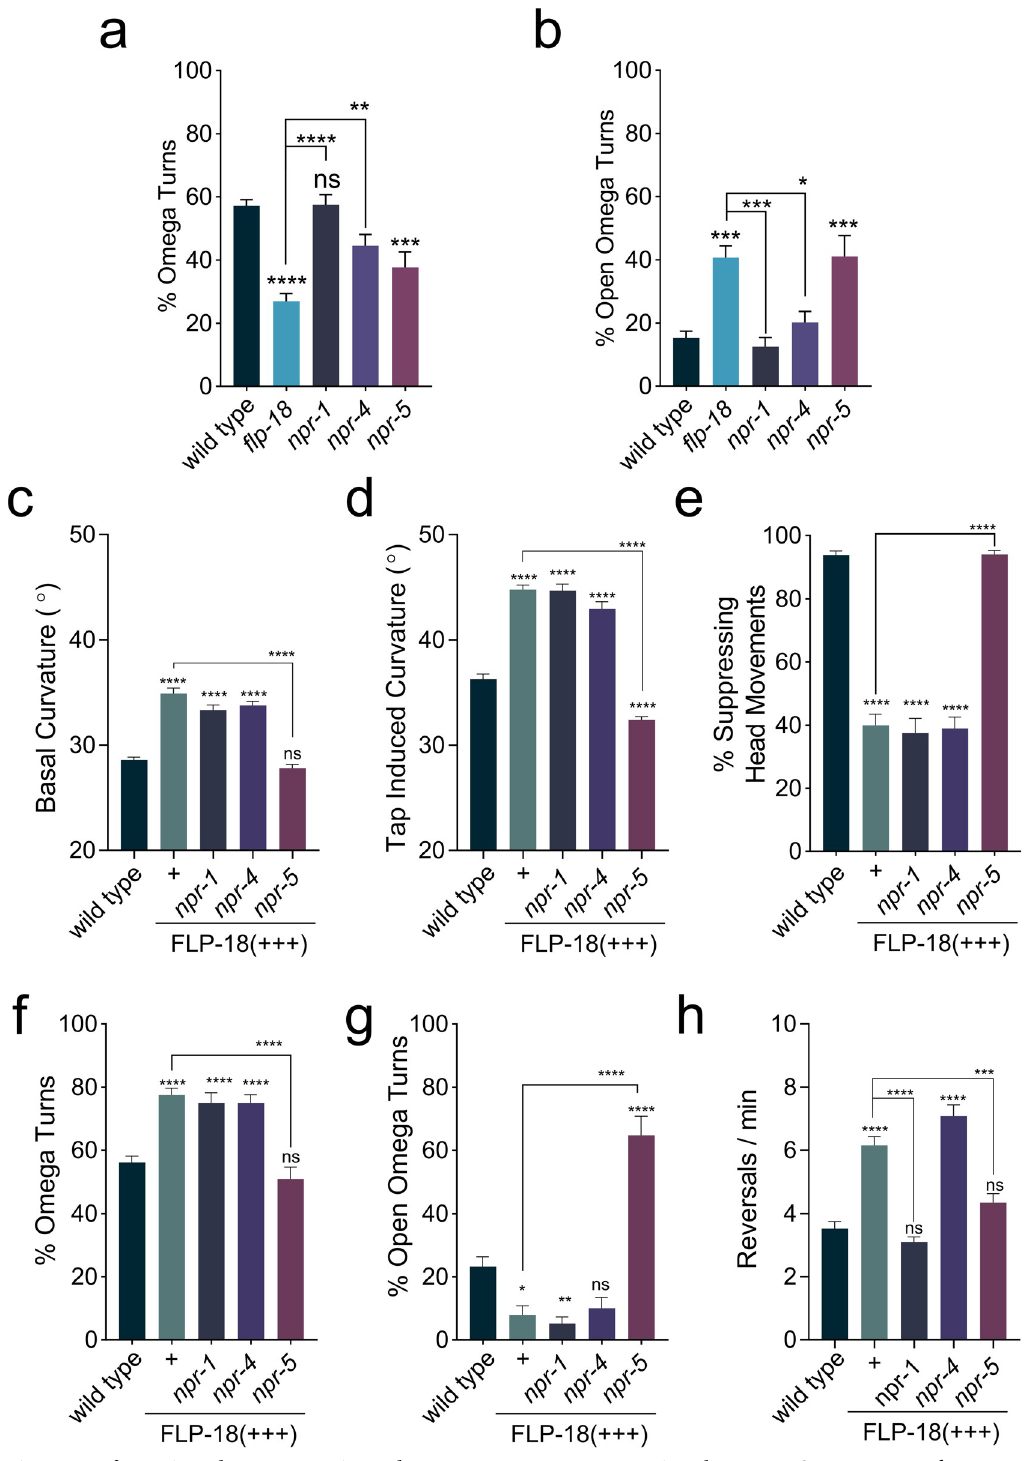
Fig 5. Loss of npr-5 impedes omega turning and suppresses FLP-18 overexpression phenotypes. Overexpression of FLP-18 causes uncoordinated locomotion, frequent reversals, and excessive bending, which is suppressed in an npr-5 mutant background. (A-B) Quantification of omega turning behavior. (A) Percentage of animals that execute omega turns in response to gentle anterior touch. (B) Fraction of open omega turns out of total omega turns. (C and D) Mean body curvature averaged over 5 seconds prior to a tap stimulus (C) or immediately following a strong tap stimulus (D). (E) Percentage of